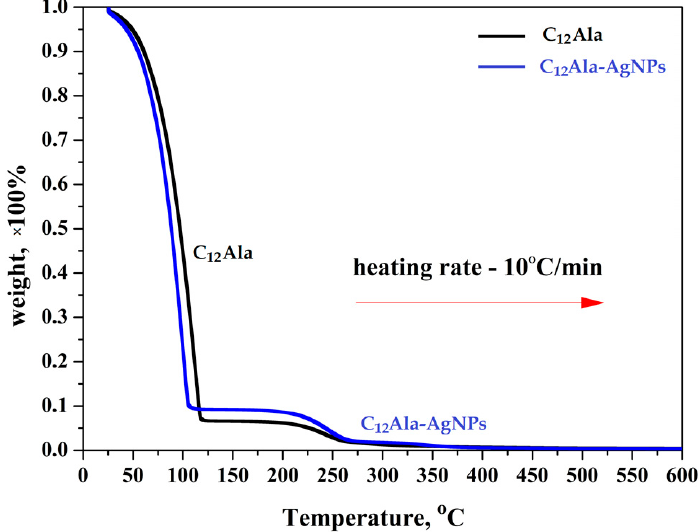
Figure 8. TGA curves of C 12 Ala and C 12 Ala-AgNPs gel samples.